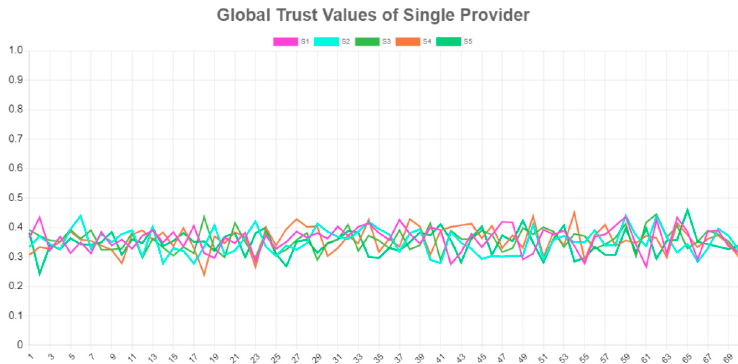
Figure 15. Global Trust Values (Tglobal) for 5 different services provided by SP4.